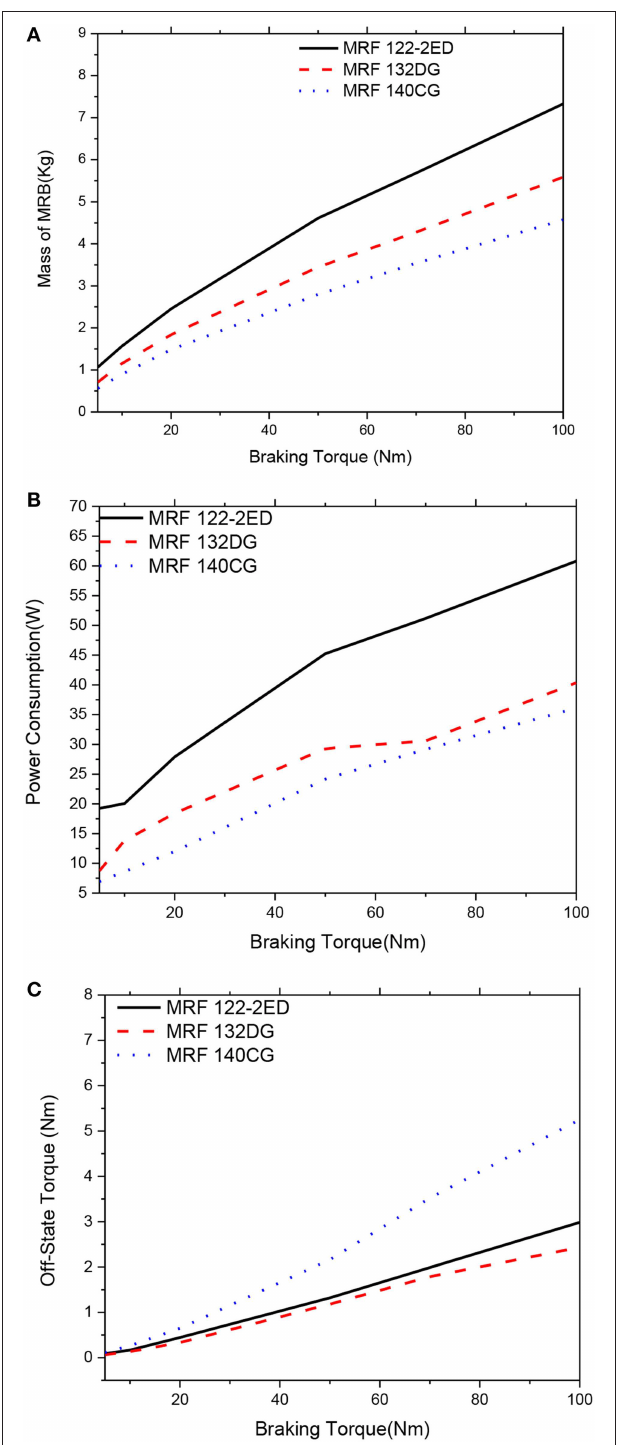
FIGURE 11 | Mass optimization results of the MRBs as a function of braking torque of side-coil MRB, d = 1.0mm. (A) Mass as a function of braking torque, (B) Power consumption as a function of braking torque, (C) Off-state torque as a function of braking torque.